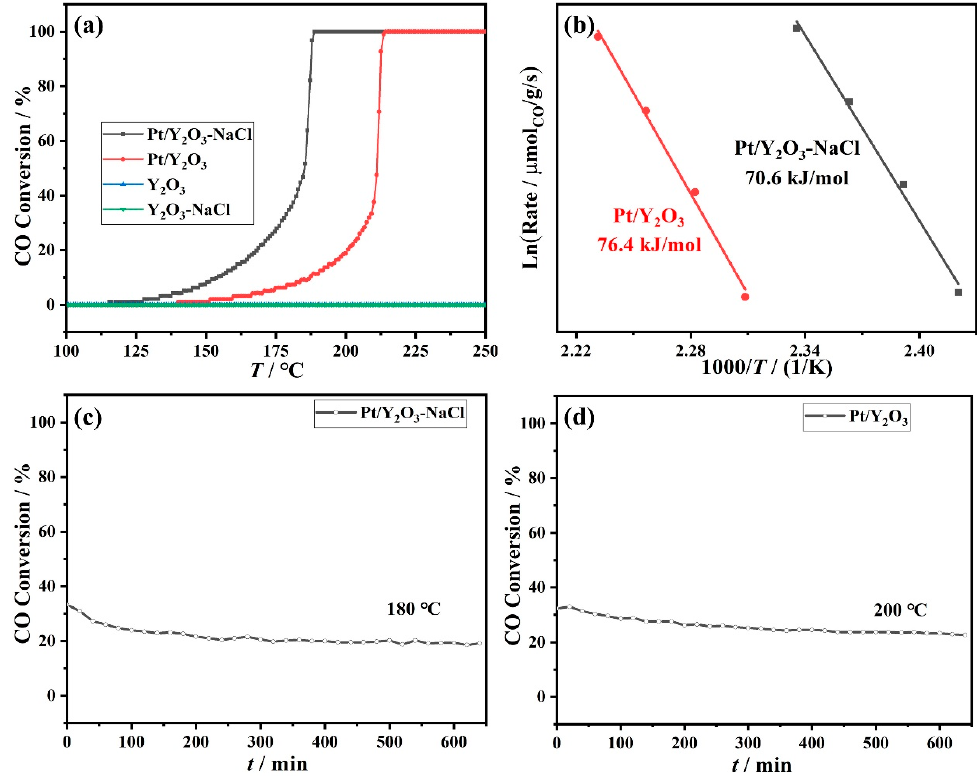
Figure 6. Catalytic performance of Pt/Y 2 O 3 -NaCl and Pt/Y 2 O 3 catalysts: ( a ) ‘light off’, ( b ) apparent activation energy ( E a ), and stability test of ( c ) Pt/Y 2 O 3 -NaCl and ( d ) Pt/Y 2 O 3 for CO oxidation.